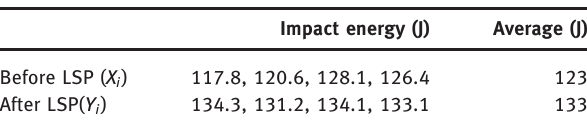
Table 3: Effect of LSP treatment on the impact toughness of Ti-17 titanium